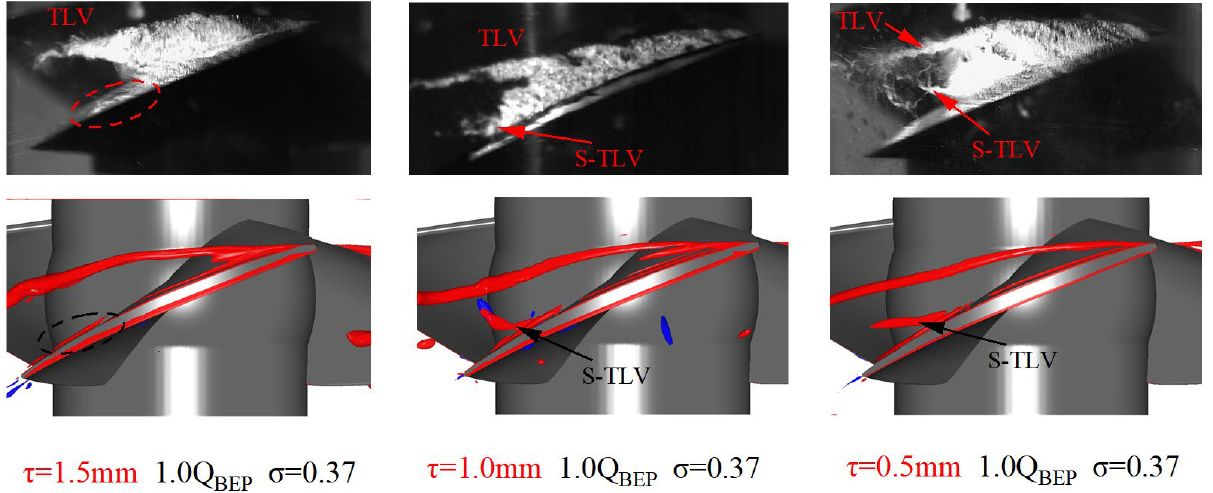
Figure 24. Cavitation images and vortex isosurface (Liutex R = 1000, Red ─ circumferential vortex, Blue ─ axial vortex) under different tip clearance sizes.